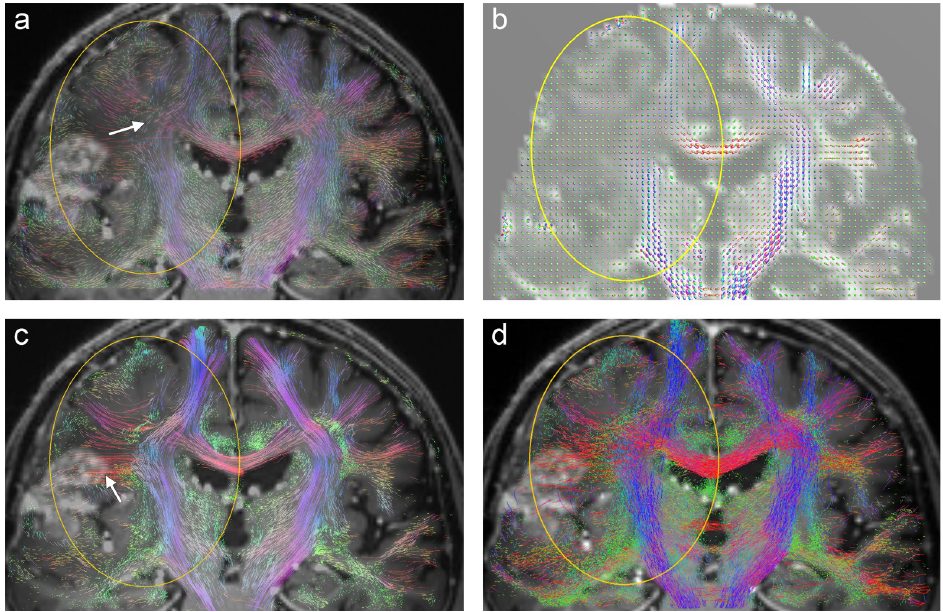
Fig 11. Visualization results from patient F (coronal slices) with region of interest (yellow): (a) A-Glyph LIC (b) CSA-ODF glyphs, deterministic (c) and probabilistic (d) tractography. In (c) a bunch of dominant fibers is visualized (arrow) which cannot be explained by the local